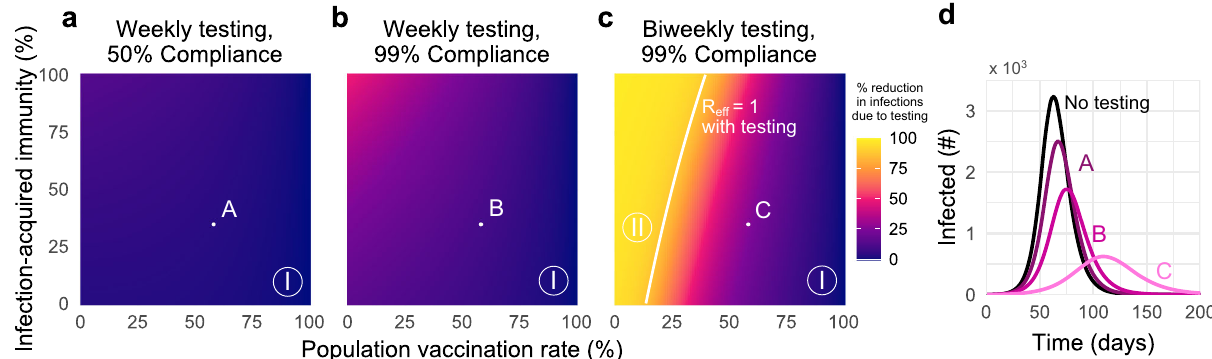
Fig. 6 Unvaccinated-only screening during omicron transmission cannot achieve R eff < 1 except in low-vaccination and high-frequency regimes. Percent reduction in cumulative infections due to screening over various population vaccination rates assuming plausible parameters for immunity vs. the omicron variant, with a once-weekly screening at 50% compliance, b once-weekly screening at 99% compliance, and c twice-weekly screening at 99% compliance. d Number of individuals infected over time, under screening scenarios denoted A, B, C, compared with no screening (black) with 58% vaccination rate and 35% rate of prior infection. Solid white line indicates R eff = 1 with screening; R eff = 1 is not achievable without screening. See Supplementary Tables 1 and 2 for parameter values. R NPI